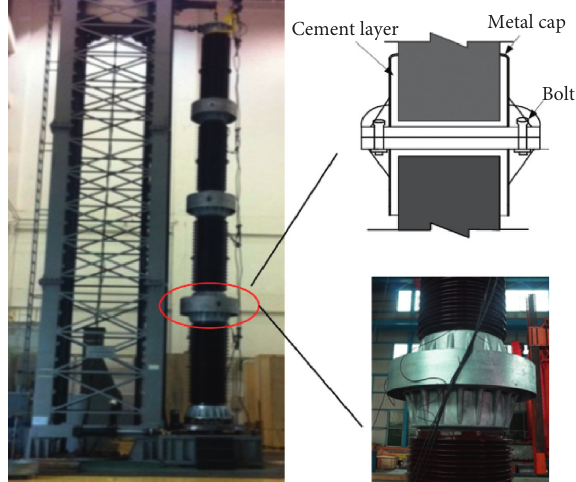
Figure 4: Porcelain pillar